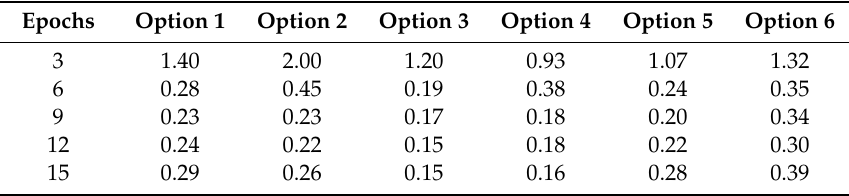
Table 10. Evolution of the average error in percentage for each option.